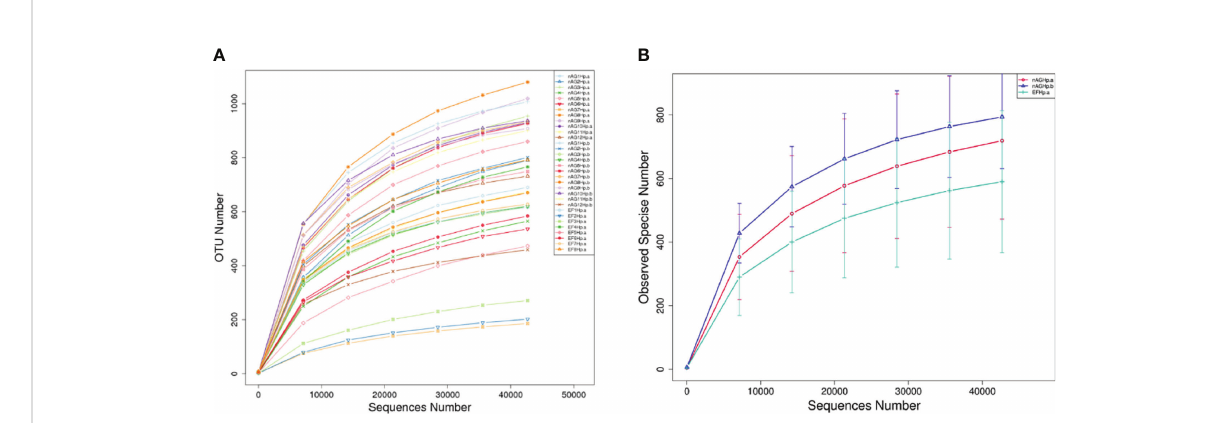
FIGURE 1 Rarefaction curves based on independent samples (A) and groups (B) . nAGHp.a, treatment-naïve patients with H . pylori infection; nAGHp.b, H . pylori -negative patients; EFHp.a, patients with refractory H . pylori